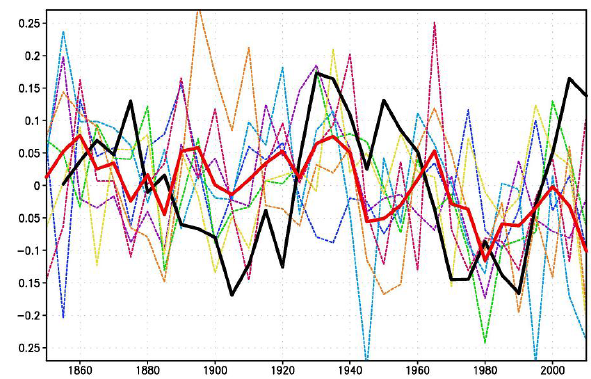
Figure 4. The 5-year mean AMO index (K) for ERSSTv4 data (thick solid black); model mean (thick solid red). Dashed thin lines represent data from individual model runs. Colors correspond to in- dividual runs as in Fig. 1.